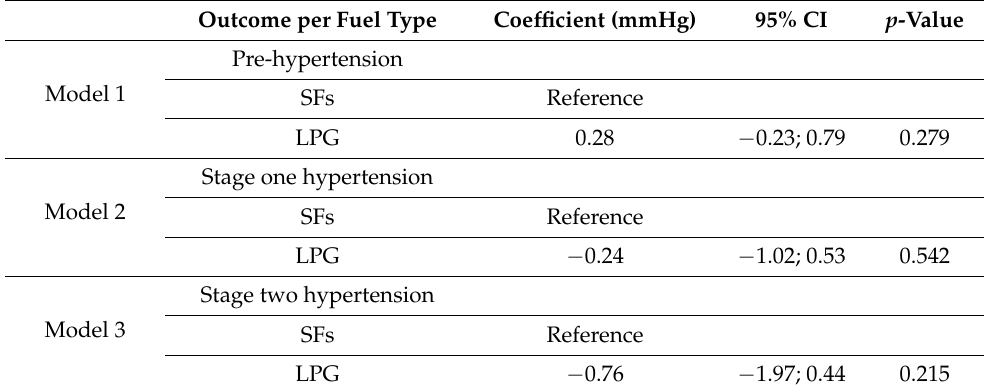
Table 2. Association between fuel use and blood pressure.